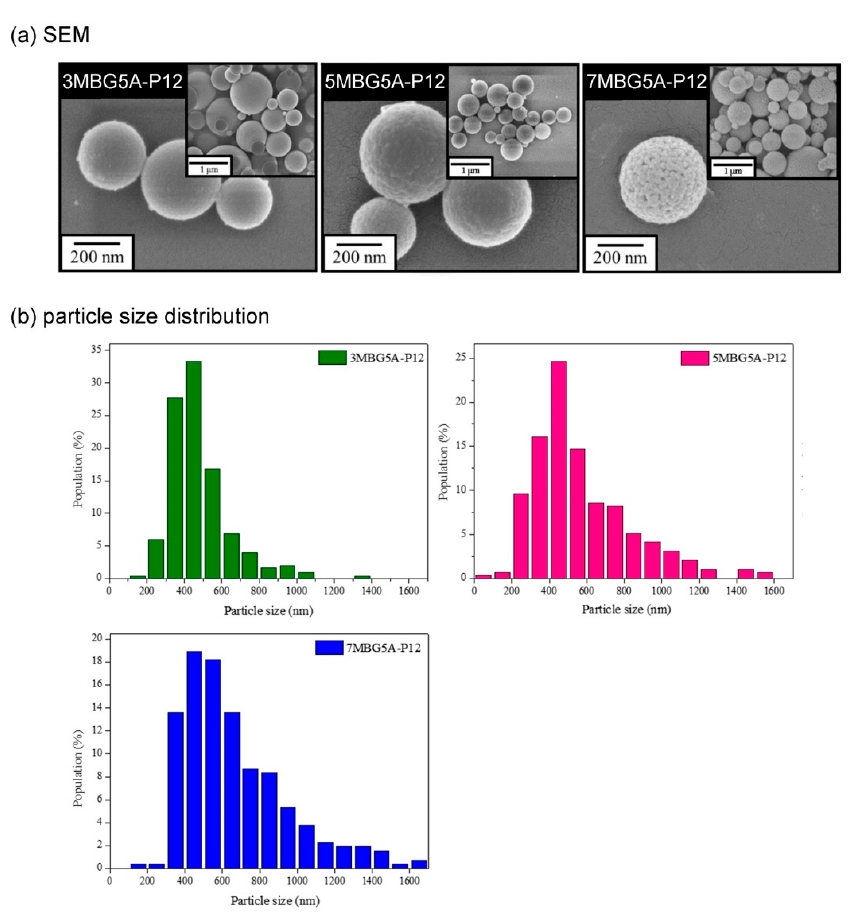
Figure 8. The FE- SEM images ( a ) and particle size distribution ( b ) of MBG adding different concentrations of PEG.